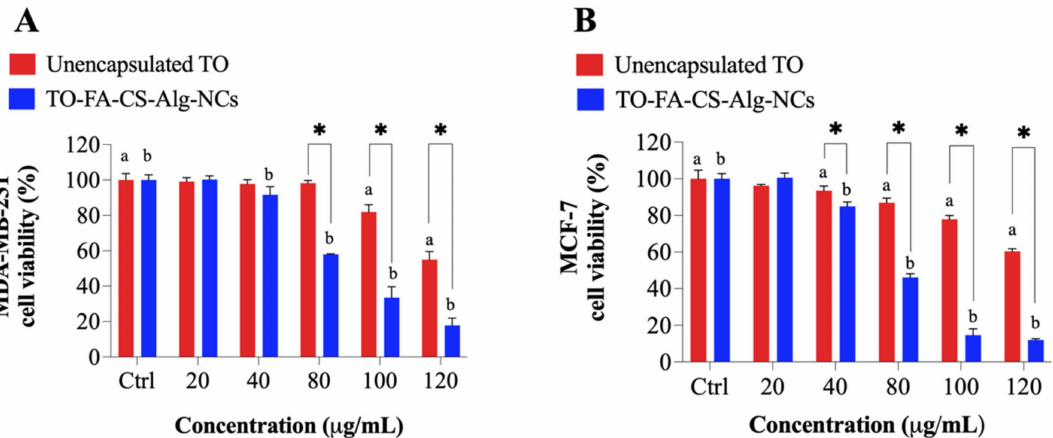
Figure 8. The viability of ( A ) MDA-MB-231 and ( B ) MCF-7 treated with unencapsulated TO and TO- FA-CS-Alg-NCs at different concentrations. a,b p < 0.05 compared to the control ( a DMSO in red and b empty FA-CS-ALG-NCs in blue), * p < 0.05 between unencapsulated TO and TO-FA-CS-ALG-NCs.